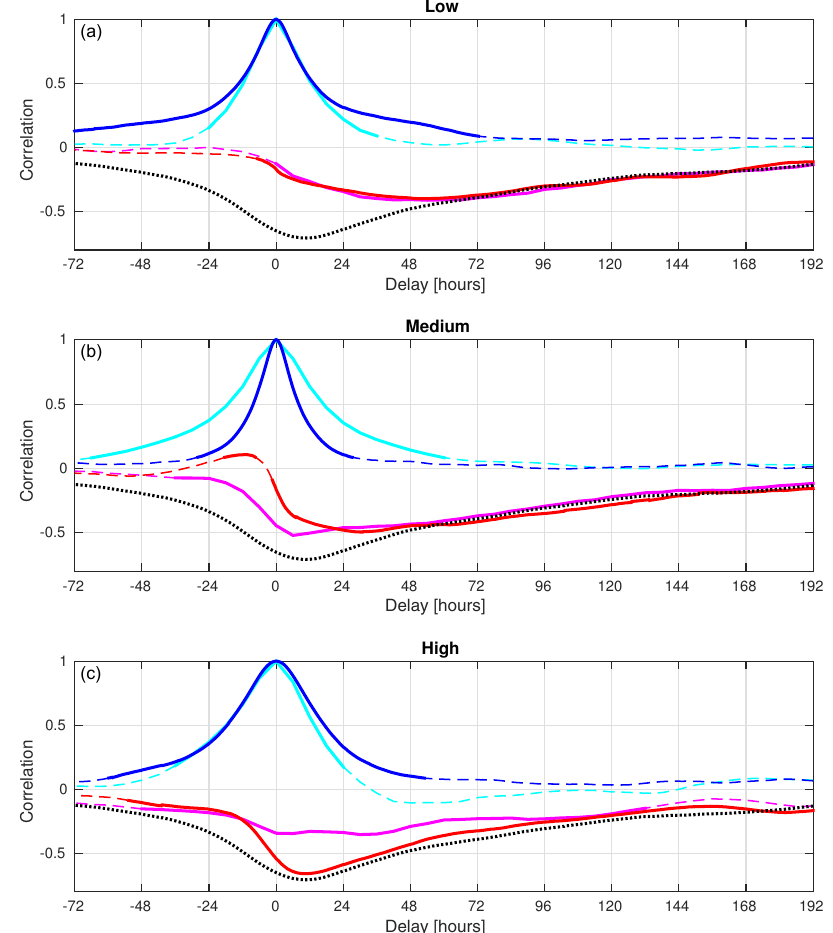
Figure 5. Cross-correlation curves for SIC and AWS (red) and ERA-Interim (magenta) wind speeds at the Laurie II AWS site for periods of low (a) , medium (b) and high (c) winds. Wind autocorrelation curves for low-, medium- and high-wind cases from AWS (blue) and ERA-Interim (cyan). Dashed lines indicate significance p > 0 . 01. The dotted black line represents the cross-correlation curve for the total of all wind cases for